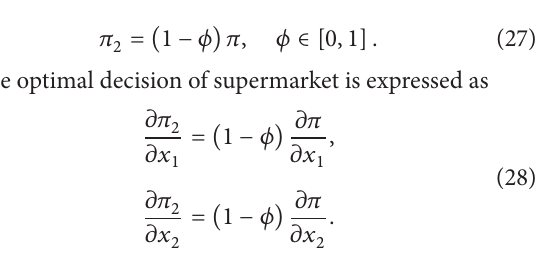
Table 1: Outcomes in the incentive model under the guidance of the cooperative.